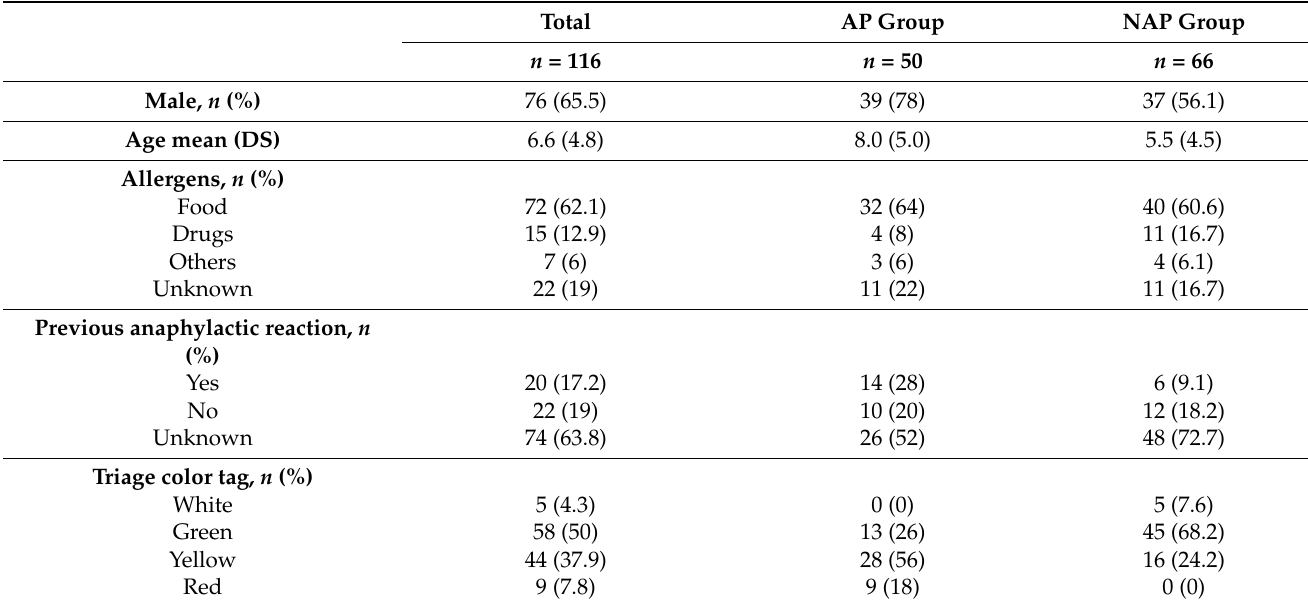
than 2 (Figure 2).